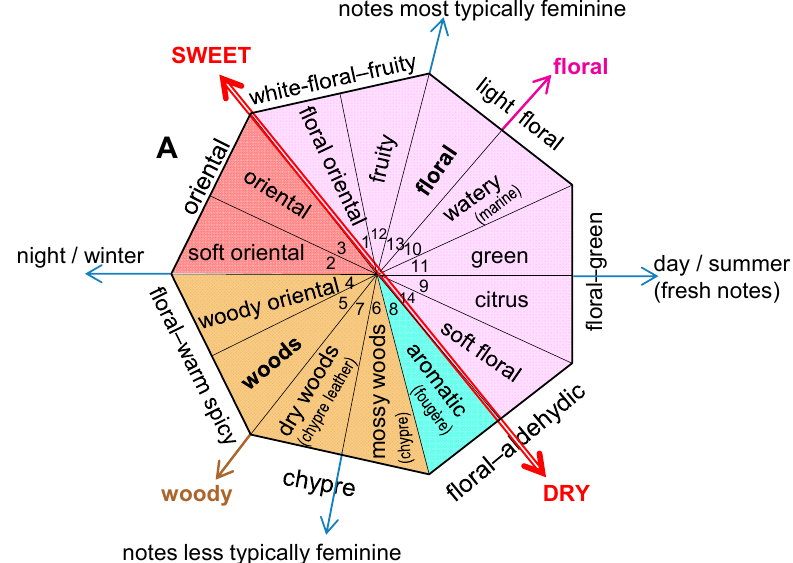
Figure 6. The Heptagon Wheel of Women’s Fragrances. Names of the 14 categories inside the heptagon correspond to the olfactory families of Edwards’s Fragrance Wheel [12]. Names outside the polygon basically correspond to Figure 3a. Four underlying polarities are indicated.